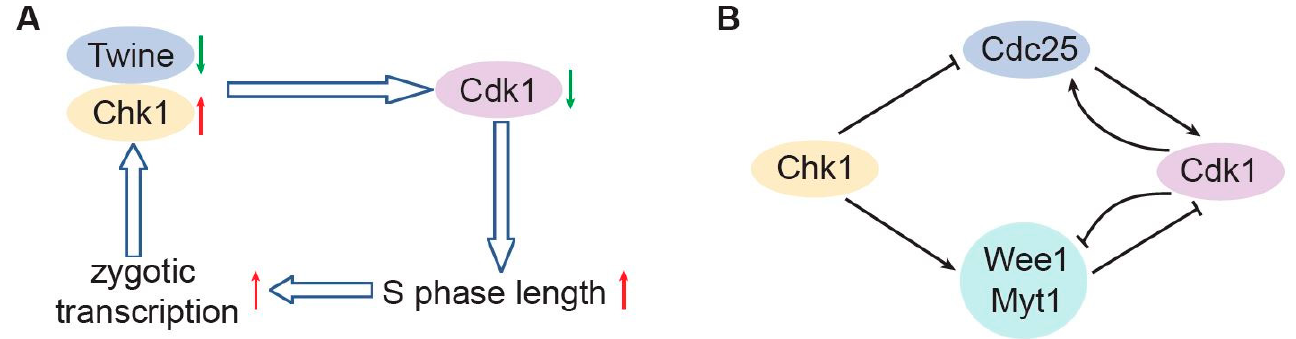
Figure 3. The embryonic cell cycle machinery contains positive feedback loops. ( A ) The positive feedback loop of zygotic transcription in Drosophila embryogenesis. ( B ) Regulatory feedback loops of Cdk1 in Xenopus .